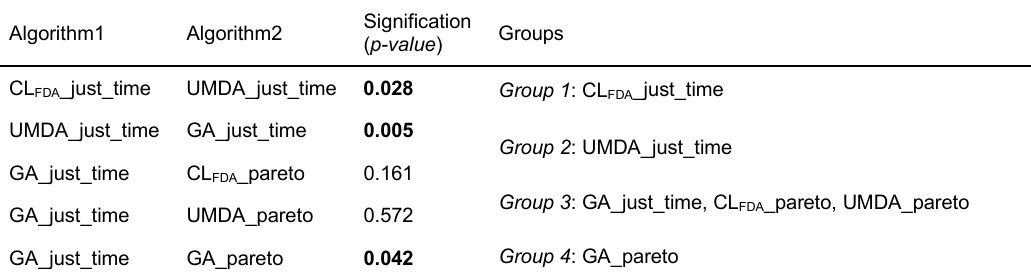
Table 6. Comparison results using Wilcoxon test, variable %Optimum , j30_17